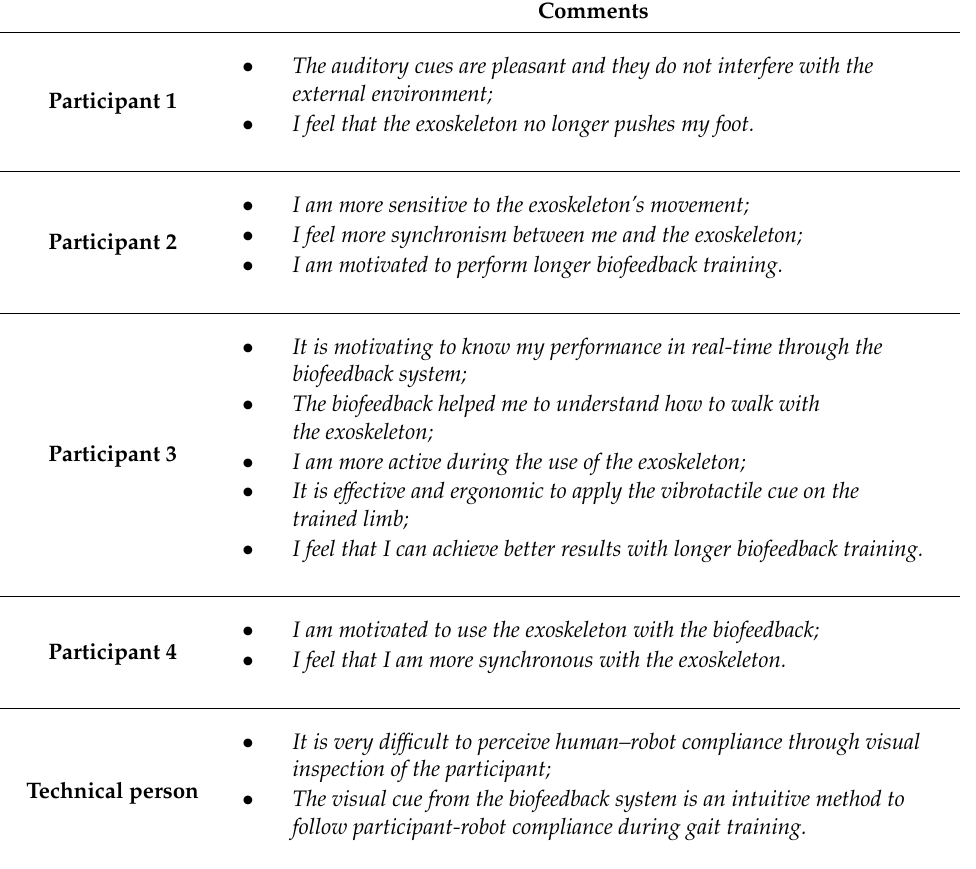
Table 5. Comments of each participant from the experimental group regarding the performed biofeedback training with both biofeedback strategies, and comments of the technical person who followed the participants during biofeedback training regarding physiotherapist-oriented strategies.